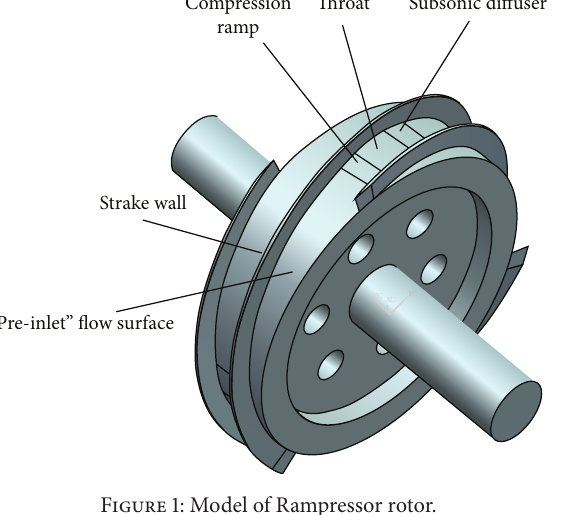
Figure 1: Model of Rampressor rotor.